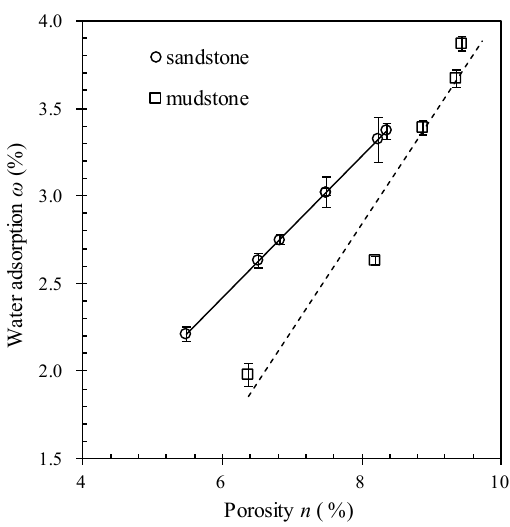
Figure 6. Relationship between the water adsorption and porosity of specimens.